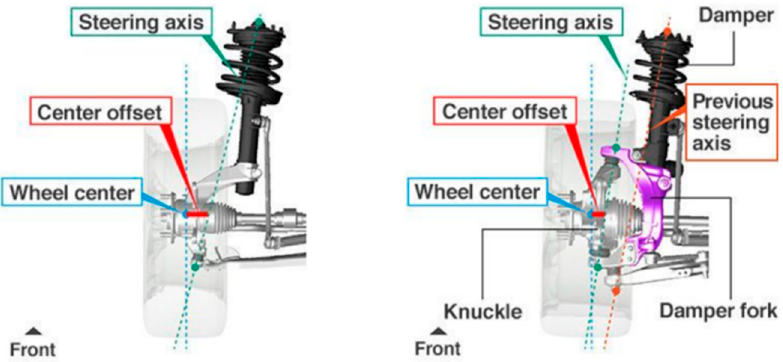
Figure 1. Special McPherson front suspension with separate steering axis (courtesy of Honda Press).